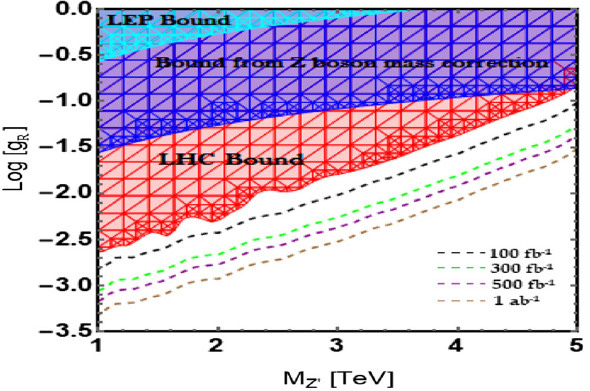
Fig. 13 Red meshed zone in M Z (cid:2) − g R plane indicates the excluded region from the upper limit on the cross-section for the process pp → √ Z (cid:2) → l + l − at 95% C.L. using ATLAS results at s = 13 TeV with 36.1 fb − 1 integrated luminosity. The cyan meshed zone is excluded from the LEP constraint. The blue meshed zone is excluded from the M Z (cid:2) / g R > 12 . 082 TeV. Black, limit on SM Z boson mass correction: 1 3 green, purple and brown dashed lines represent the projected discovery reach at 5 σ significance at 13 TeV LHC for 100 fb − 1 , 300 fb − 1 , 500 fb − 1 and 1 ab − 1 luminosities